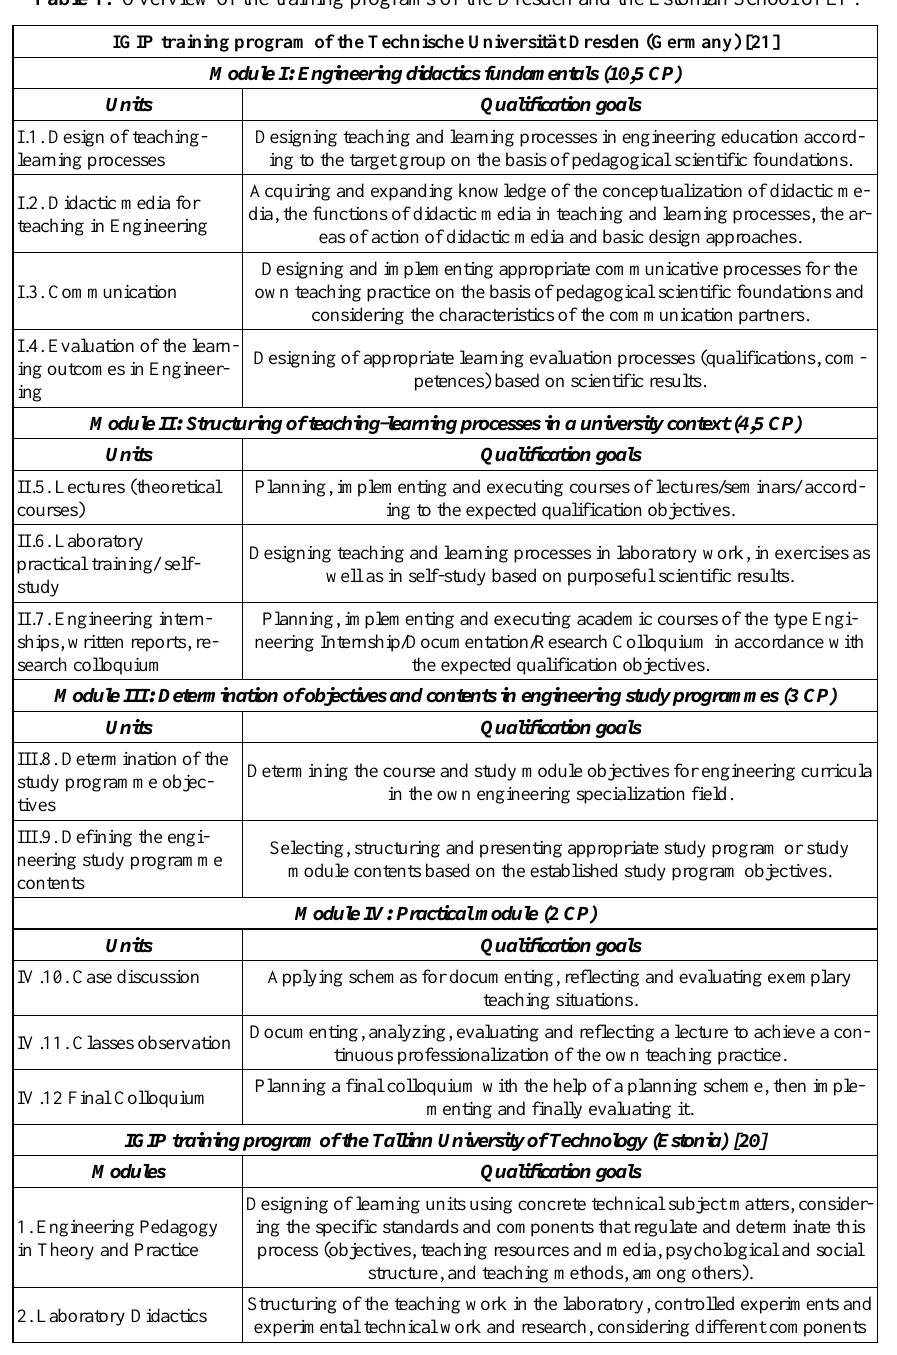
Table 1. Overview of the training programs of the Dresden and the Estonian School of